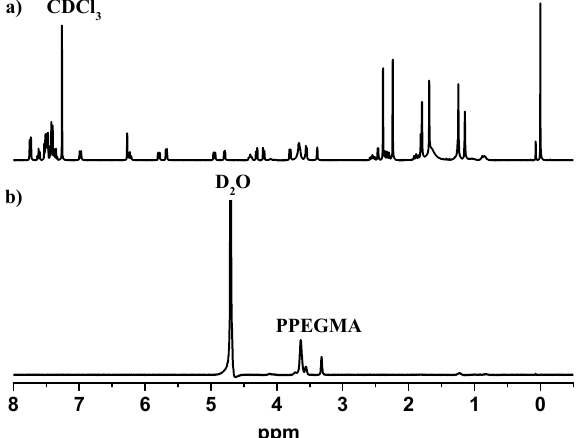
Figure 5. 1 H NMR spectra of PTX-loaded micelles in CDCl 3 - d ( a ); PTX-loaded micelles in D 2 O ( b ). Table 2. The properties of blank and paclitaxel (PTX)-loaded micelles.